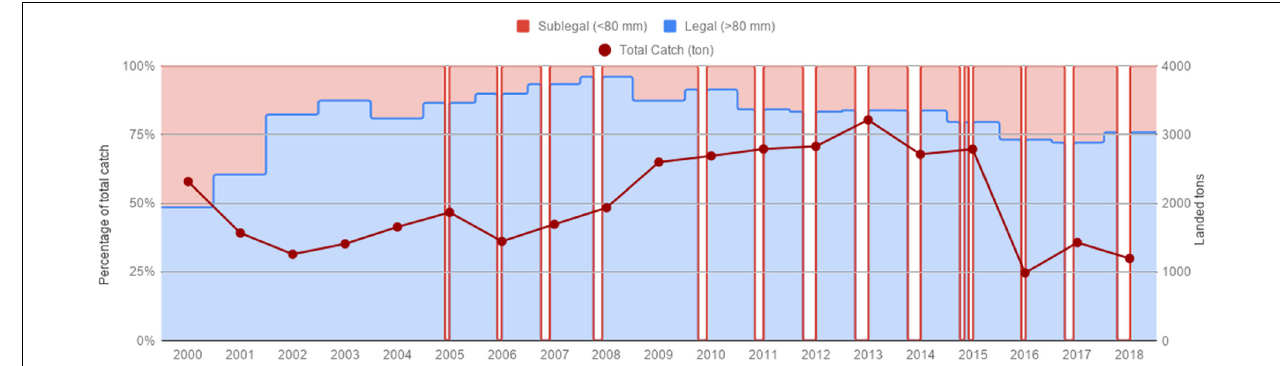
FIGURE 2 | Total catch/landings for the red sea urchin fishery from 2000–2018. Percentage of legal and sub legal red sea urchins represent monthly catches. Gaps represent closed seasons.